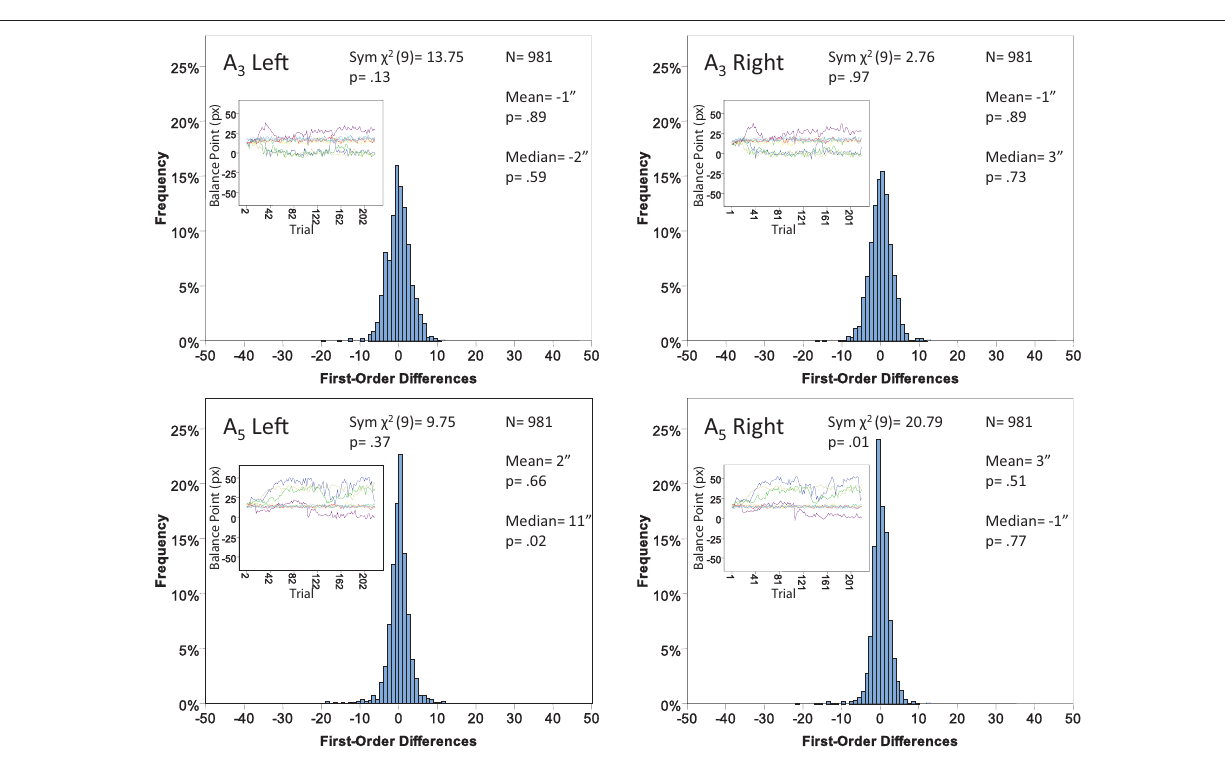
Figure 14 | Histograms of the ∆ ’s for the shape experiment, participant P6. The rest as in Figure